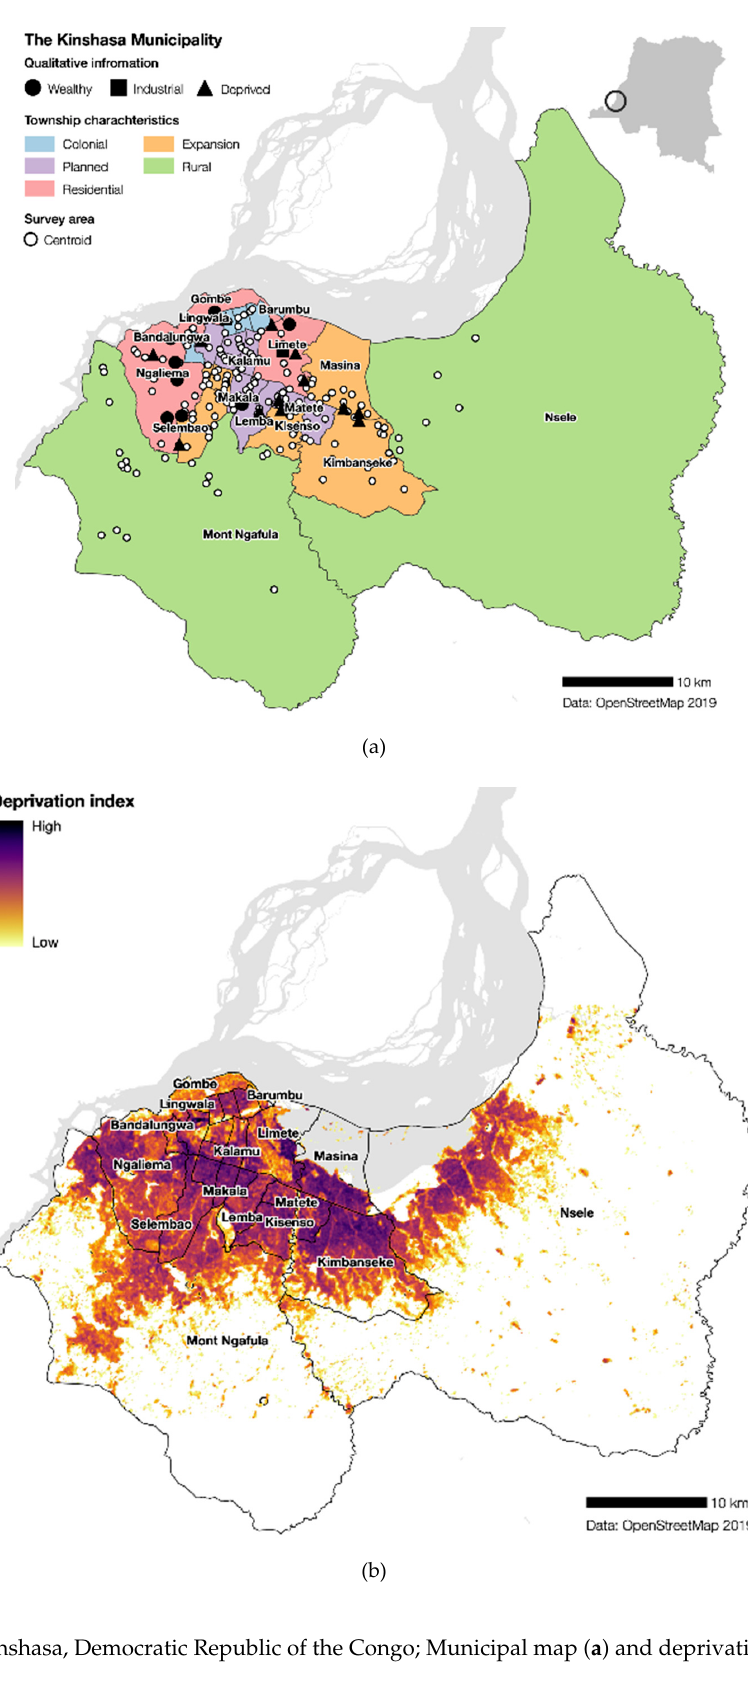
Figure 6. Kinshasa, Democratic Republic of the Congo; Municipal map ( a ) and deprivation index ( b